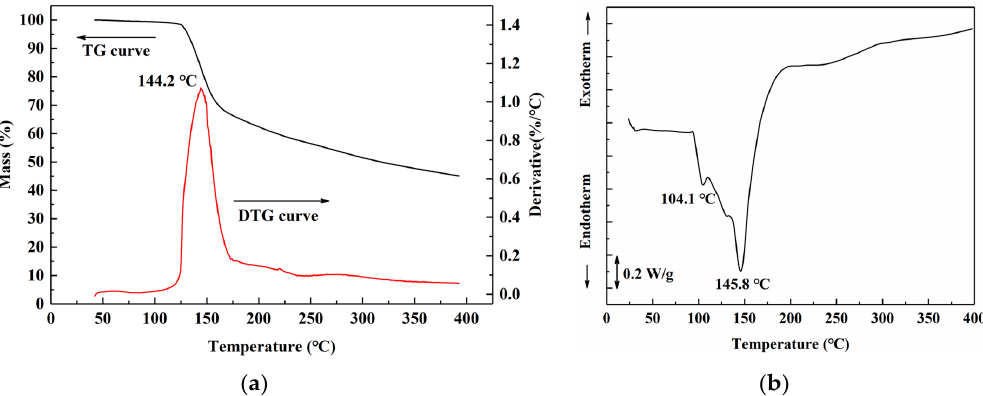
Figure 6. ( a ) Thermo gravimetric (TG) and derivative thermo gravimetry (DTG) curves, and ( b ) differential scanning calorimetry (DSC) curve of SADP adhesive.